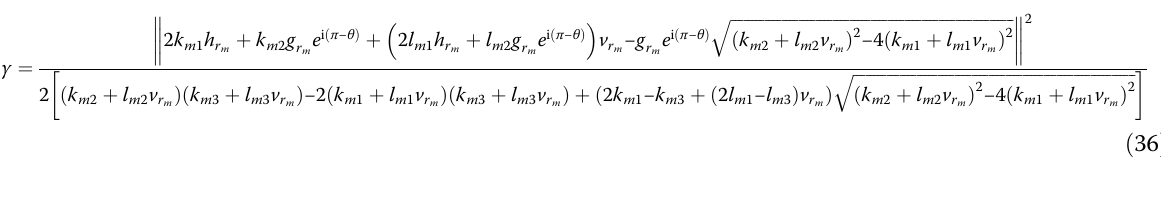
Fig. 2 The revenue U r